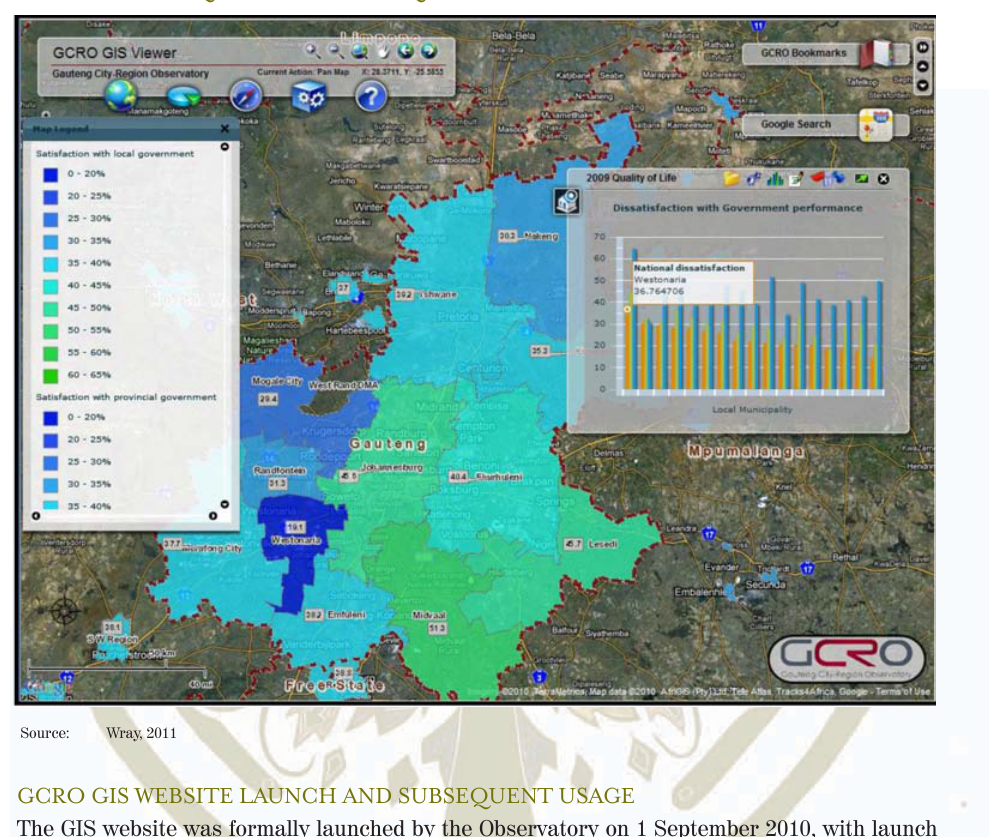
QUALITY OF LIFE (QOL) DYNAMIC THEME WITH